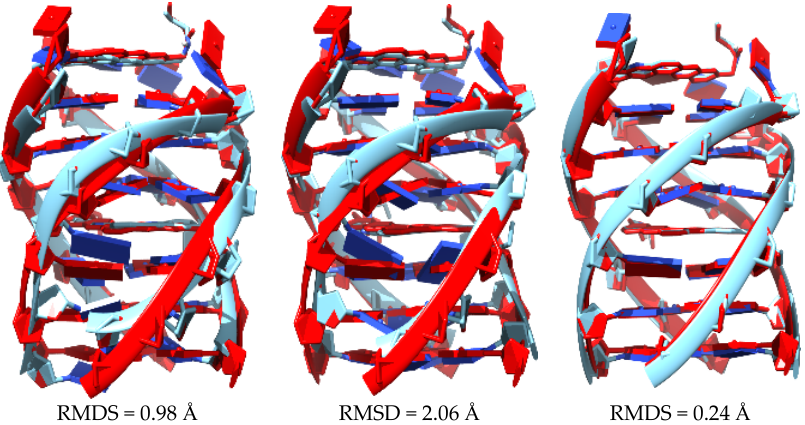
Figure 29. Superposition of the reference PDB structure (PDB ID: 2jwq in red) with the optimized geometries (in cyan) at the PM6-DH2 ( left ), PM7 ( middle ) and LMKLL/DZ2P ( right ) level of theory. RMSD is also included. The conclusion that the semi-empirical PM6-DH2 and PM7 and the LMKLL/DZ2P